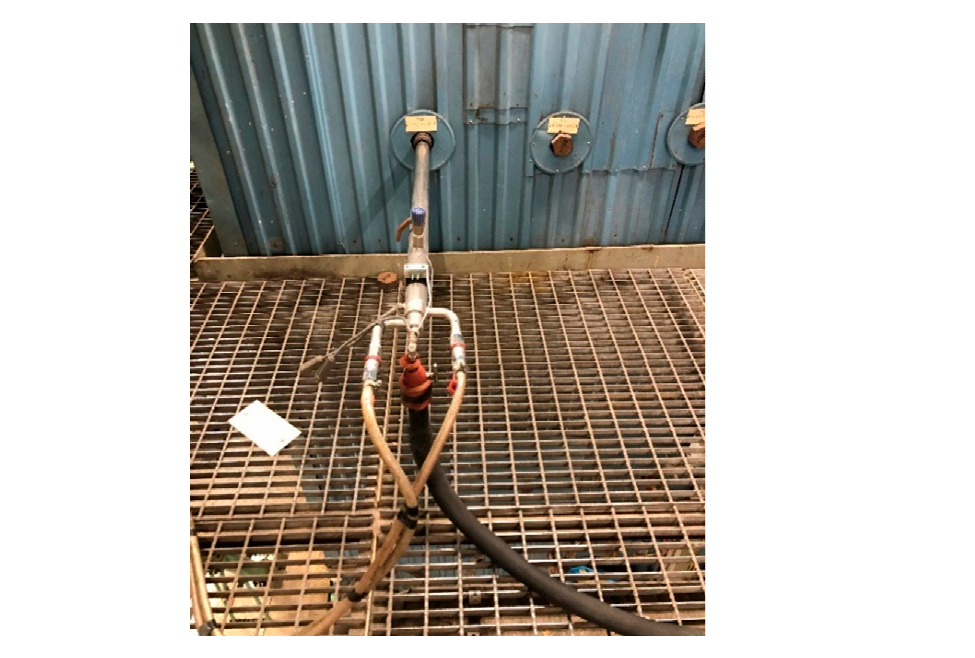
Figure 12. Flue gas sampling probe applied in the measurements performed over the cross-section of the combustor.